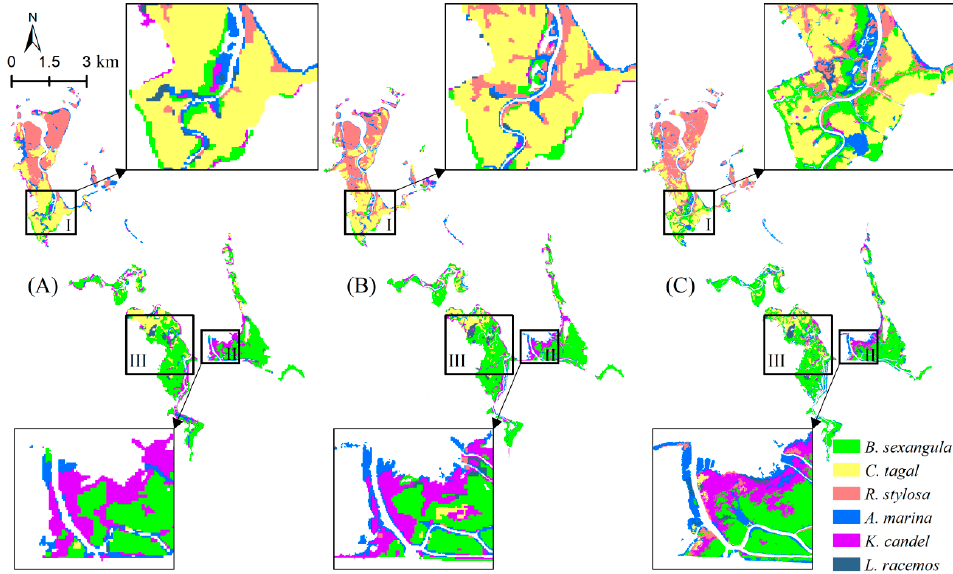
Figure 6. Comparison of ( A ) Landsat 8, ( B ) Sentinel-2, and ( C ) Pléiades-1 imagery for mangrove species community classifications.